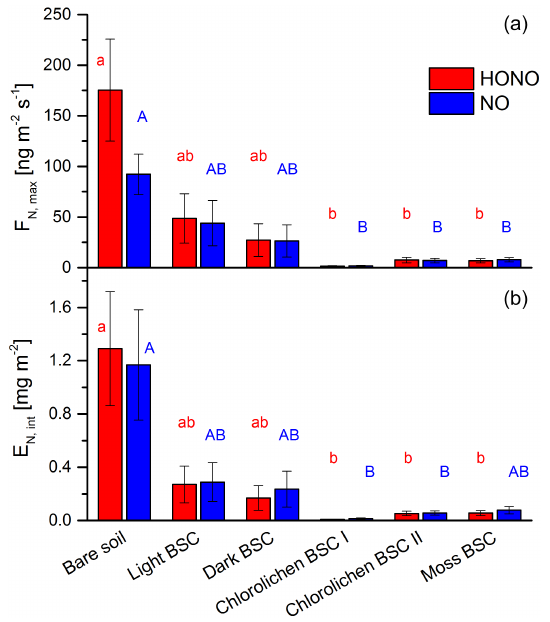
Figure 5. Emission of HONO and NO from bare soil and biocrusts. Panel (a) shows maximum HONO-N and NO-N fluxes (ngm − 2 s − 1 ) at optimum water conditions. Panel (b) shows emis- sions integrated over a whole wetting–drying cycle (mg(N)m − 2 ); letters show significant difference ( p = 0.05, of log-transformed data); error bars indicate standard error of the mean of replicates (bare soil n = 3; light BSC n = 4; dark BSC n = 5; chlorolichen BSC I n = 3; chlorolichen BSC II n = 6; moss BSC n =